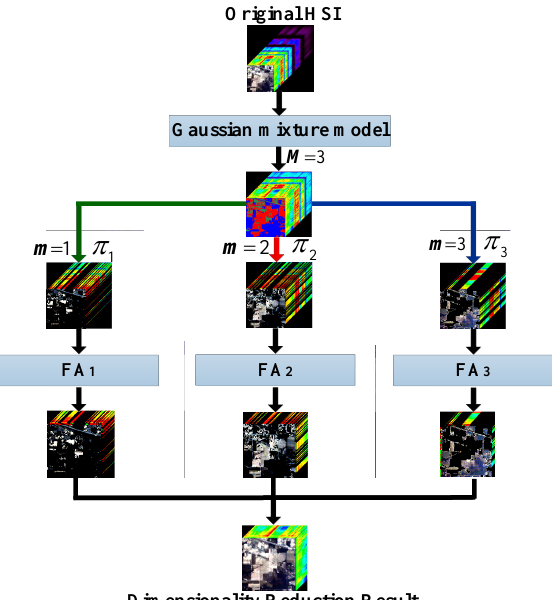
Figure 2. The schematic of the MFA corresponding to Figure